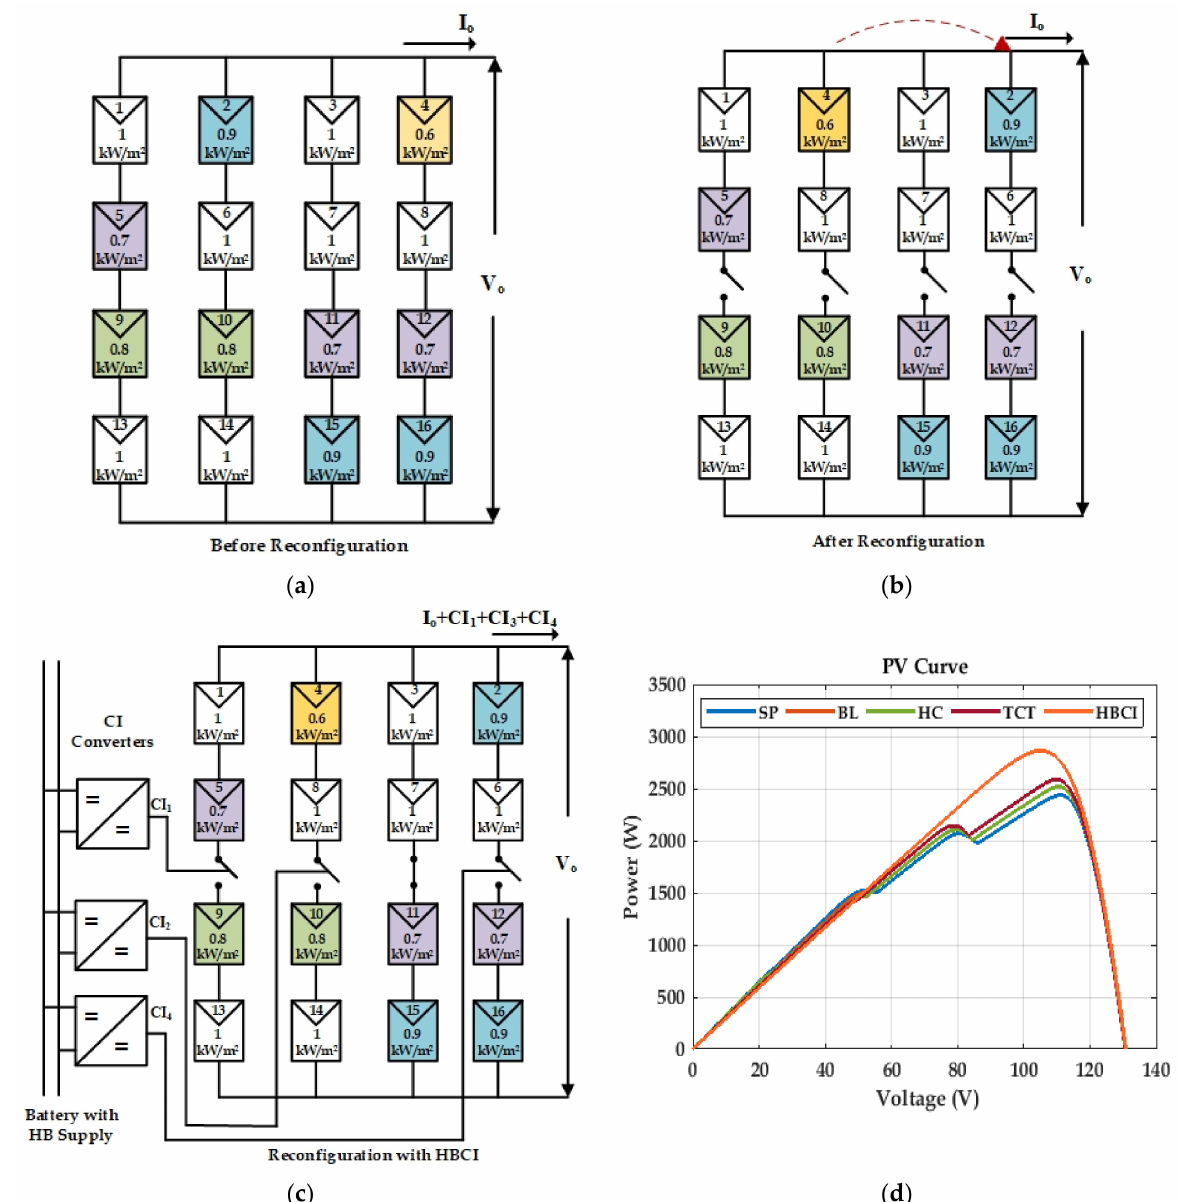
Figure 12. Case 4: random shading: ( a ) the SP array configuration; ( b ) after reconfiguration with HBCI; ( c ) reconfiguration with HBCI; ( d ) PV